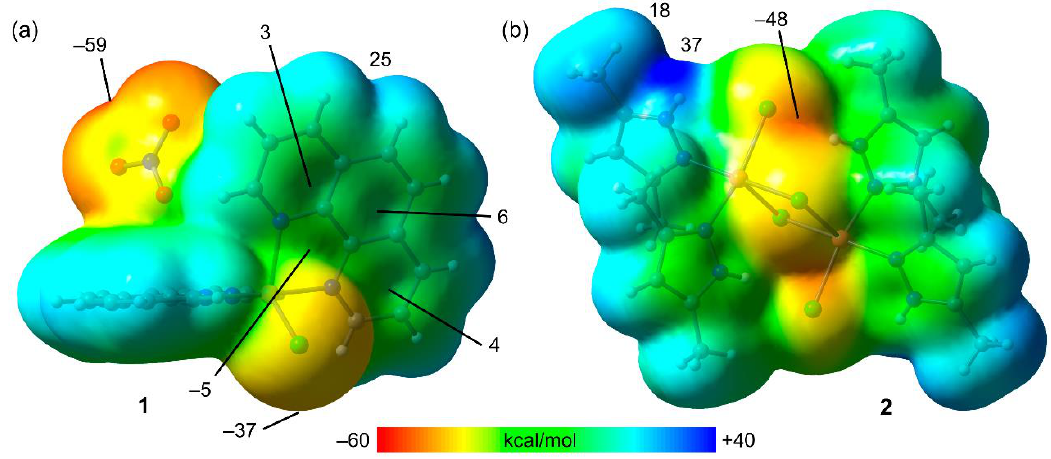
Figure 6. MEP surfaces of compounds 1 ( a ) and 2 ( b ) at the RI-BP86-D3/def2-TZVP level of theory. The isovalue was 0.001 a.u., and the energies at selected points are indicated in